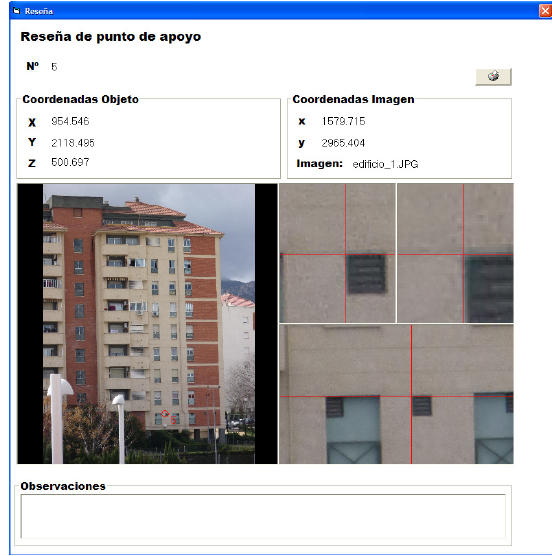
Figure 4. Model of point